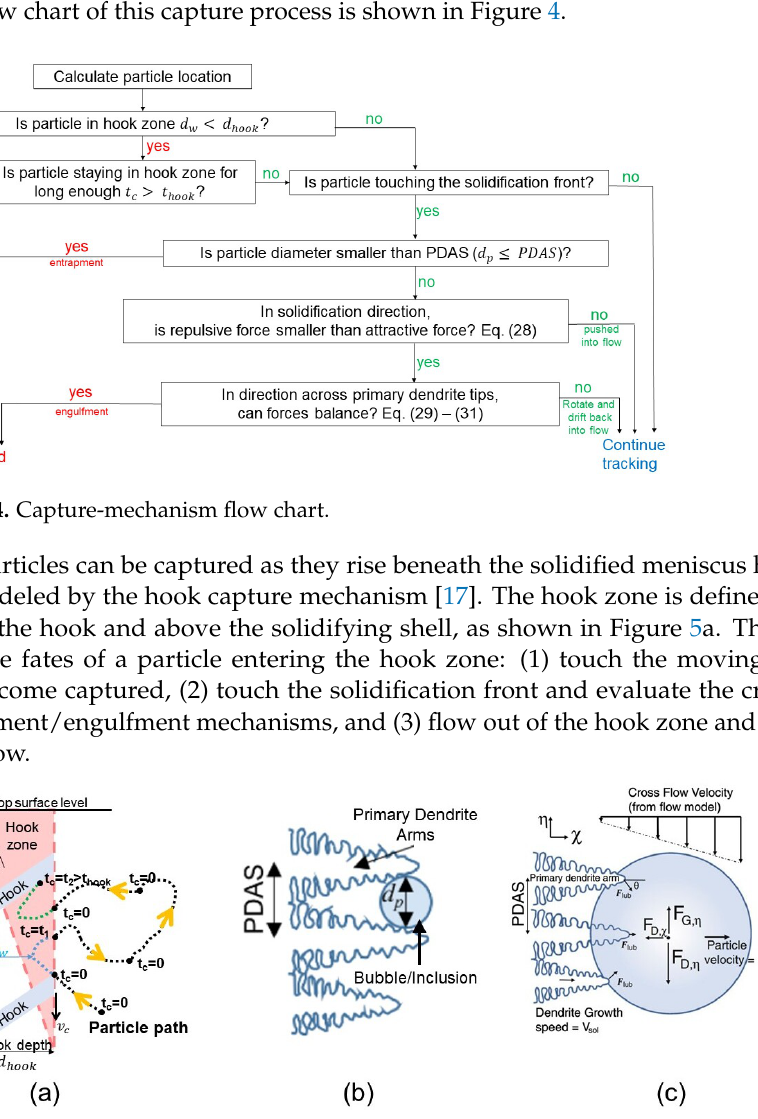
Figure 5. Capture mechanism schematic: ( a ) capture by a downward-moving hook; ( b ) entrapment in between primary dendrites arms; ( c ) engulfment by a growing solidification